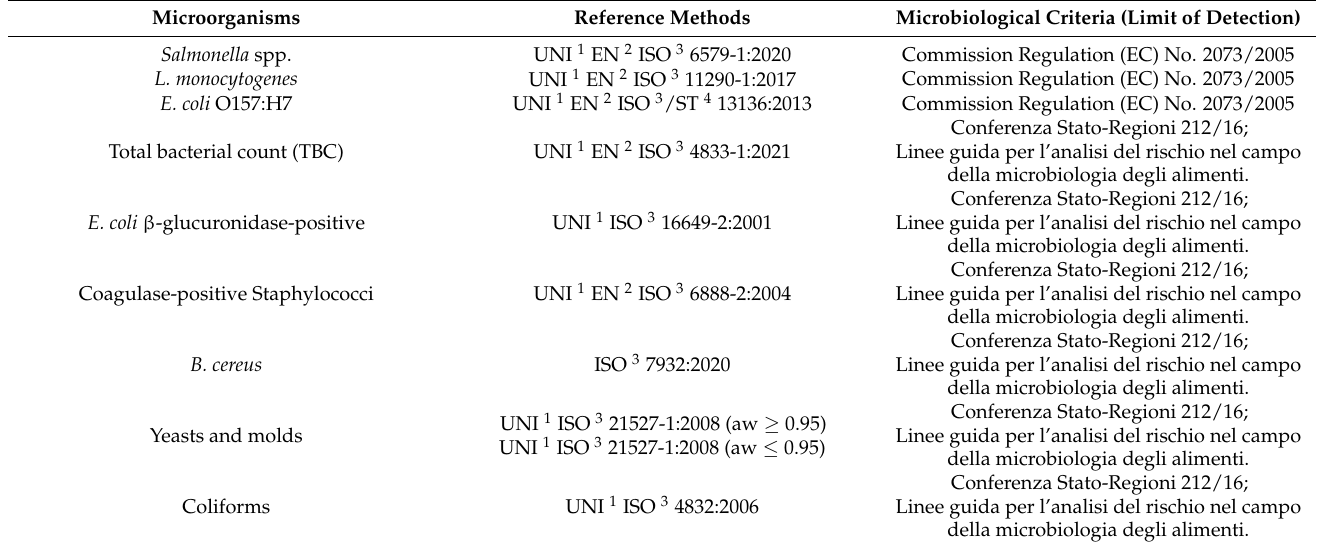
Table 2. Microorganisms, reference methods and limit of detection used in the microbiological analyses of spoilage, pro-technological and pathogenic microorganisms. Microorganisms Reference Methods Microbiological Criteria (Limit of Detection) Salmonella spp.